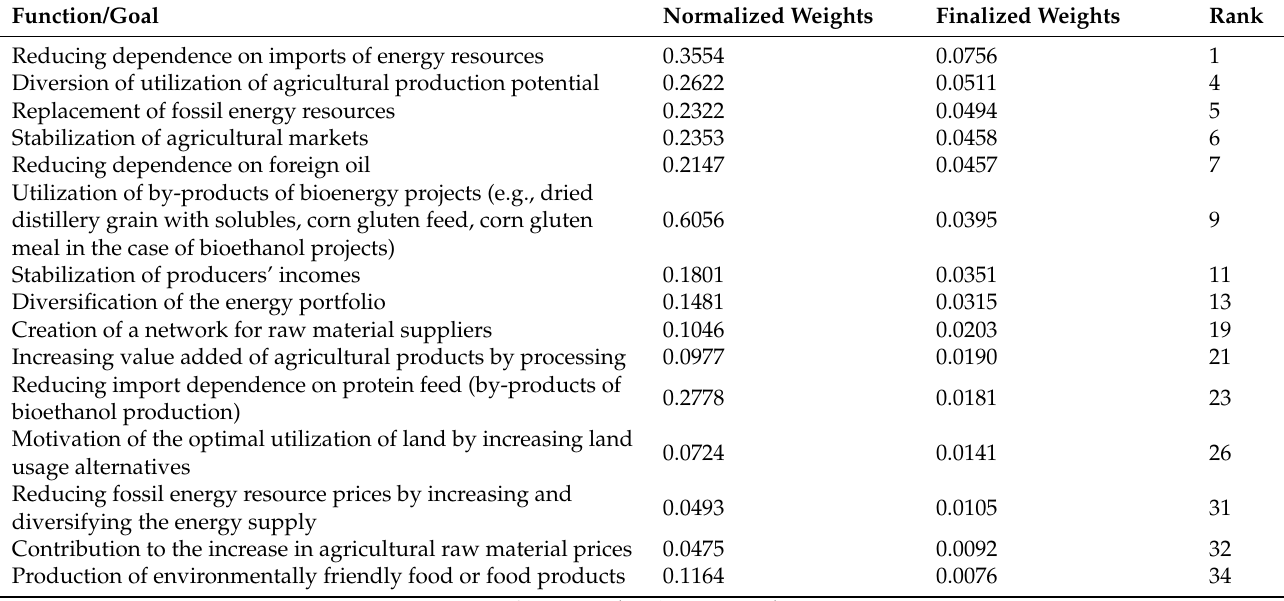
Table 10. Relative importance of different sub-criteria ordered by ascending rank order of sub-criteria. Function/Goal